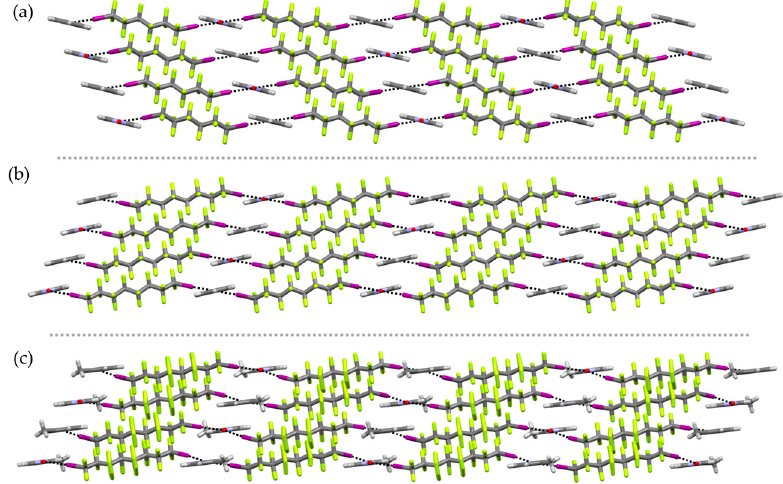
Figure 2. Section of the crystal packing showing structural similarity between 1-D parallel stacks in 1•DI6 ( a ), 1•DI8 ( b ) and 3•DI8 ( c ).